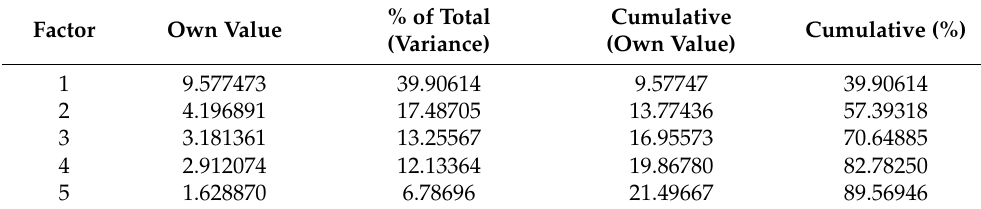
Table 2. Groups of factors and their eigenvalues describe the quality of life.